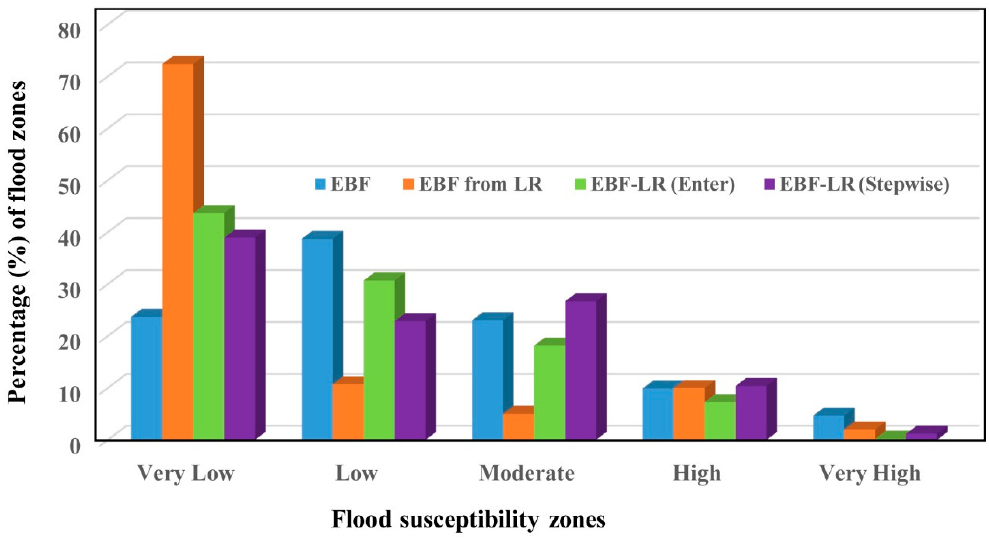
Figure 8. A histogram showing the percentage of flood zones that fall into the various classes from the four models. four